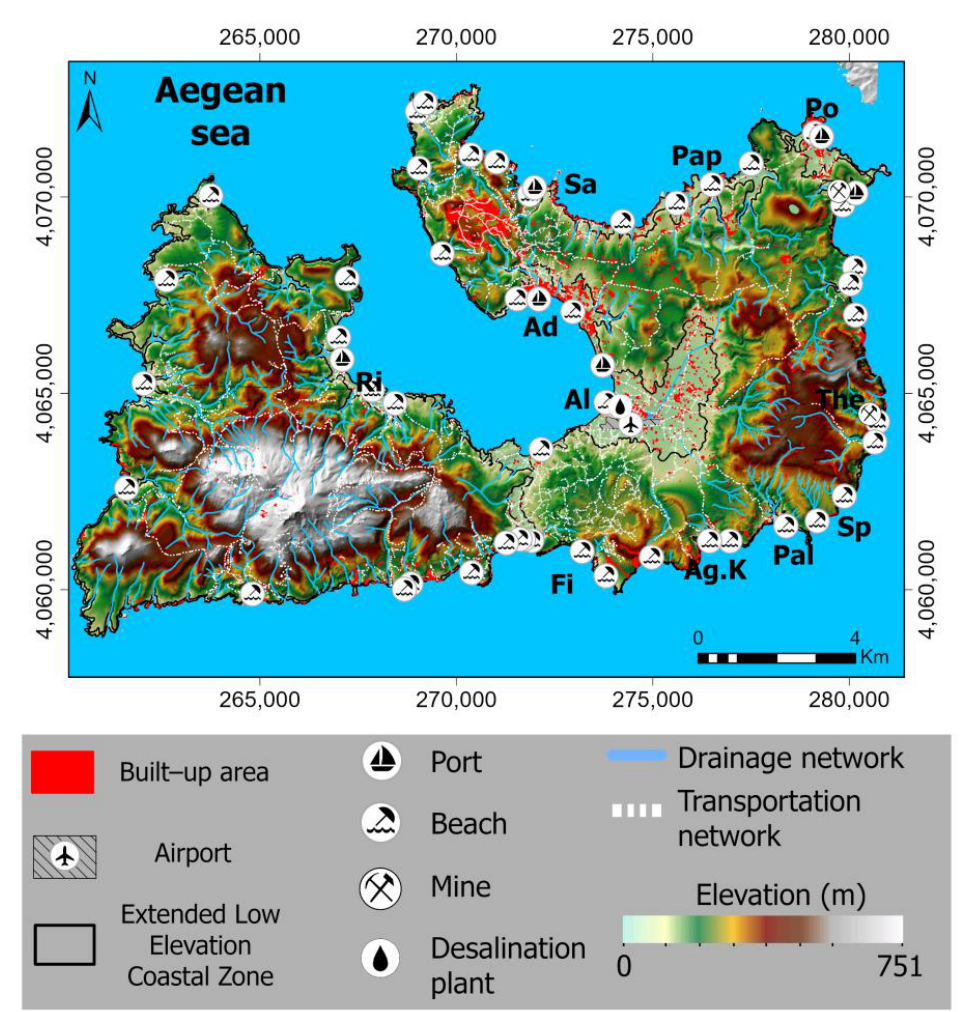
Figure 2. Digital Elevation Map of Milos Island illustrating the input of geospatial analysis, such as seaports, beaches, desalination plant and mines. Ad: Adamas, Al: Alikes, Po: Posidonia, Ri: Rivari Lagoon, Pal: Palaiochori, Pap: Papafragas, Fi: Firiplaka, Sa: Sarakiniko, Sp: Spathi, Th: Thiorichio and Ag.K: Agia Kiraki.